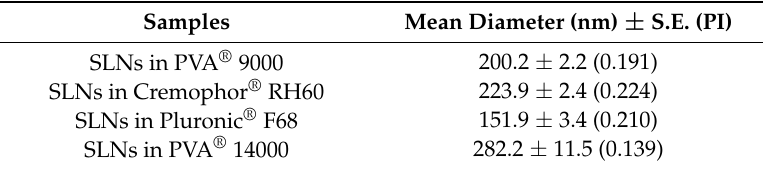
Table 3. Mean diameter (nm) ± standard error (PI) of empty solid lipid nanoparticles (SLNs) dispersed in different 2% w/w polymer